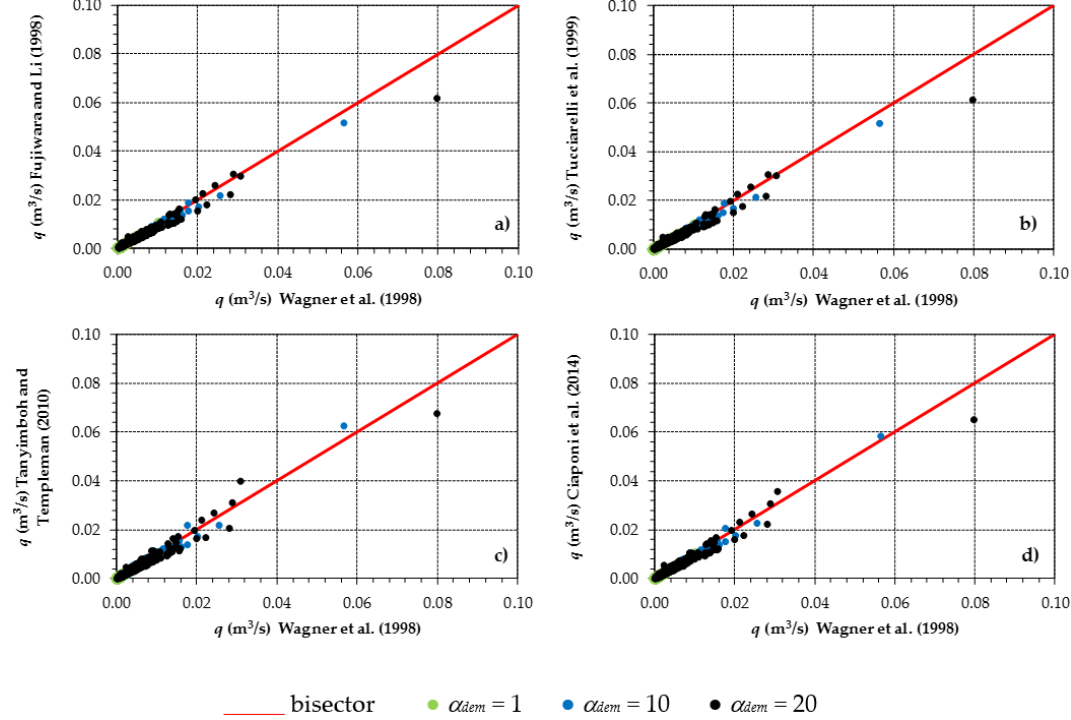
Figure 8. Second case study. Number k of iterations as a function of α dem for the various formulations.